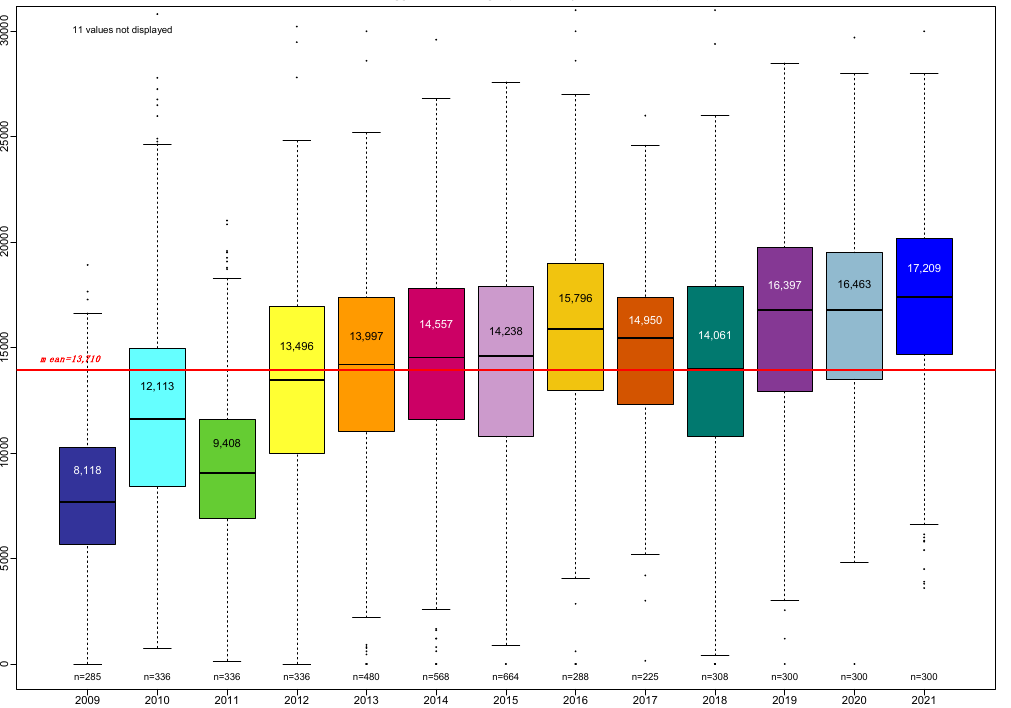
Figure A1. Evolution of the average number of capped brood cells per year from 2009 to 2021.